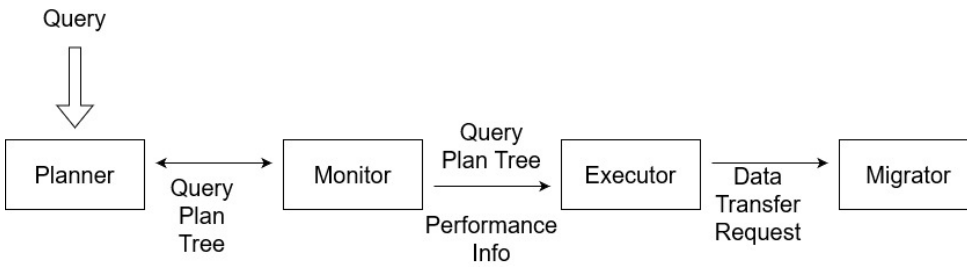
Figure 3. BigDAWG Components